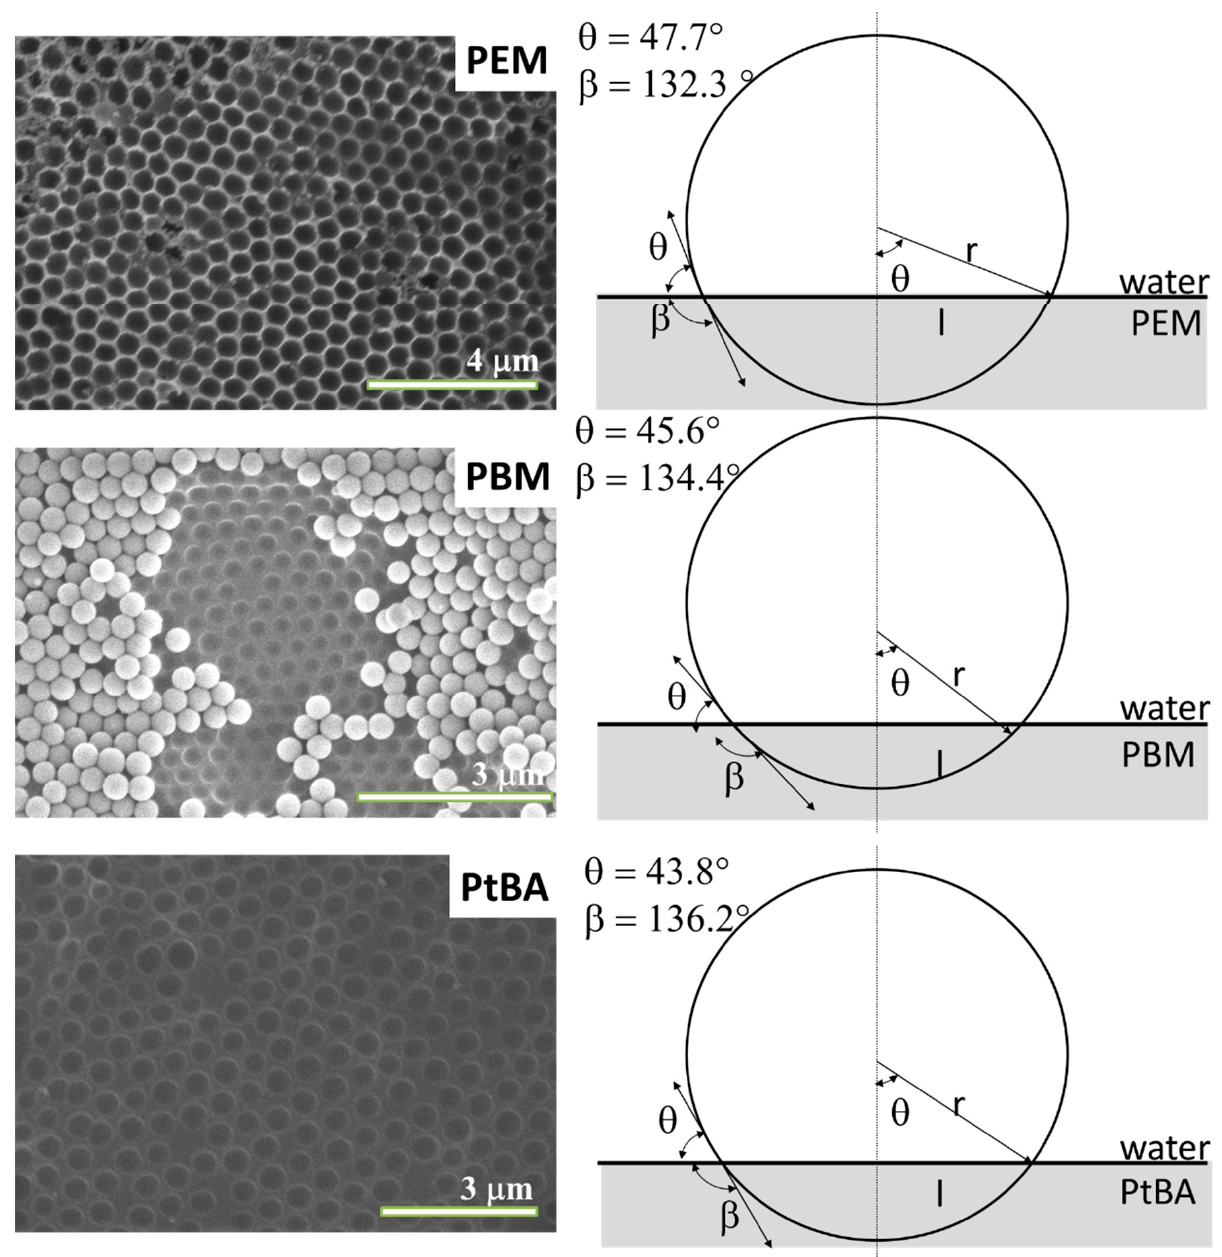
Figure 3. SEM images of the circular traces left by NP-L on the surface of PEM, PBM and PtBA microspheres. The cartoons on the right represent the immersion depth of the nanoparticles at the interface that can be fully described by the contact angle values θ with the water and β with the organic phase. In the image the l represents the diameter of the circular trace determined by SEM, and r represents theradius of the